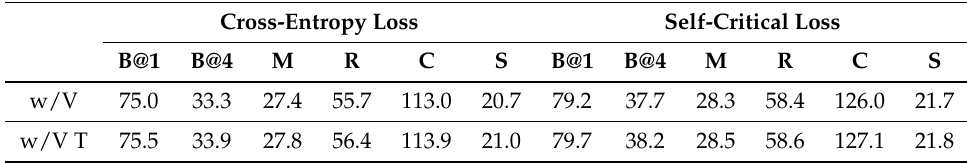
Table 4. Experiment results of the ablation study of our model when the decoder takes the visual features “V”, or takes both the visual features “V” and the textual features “T” as the information